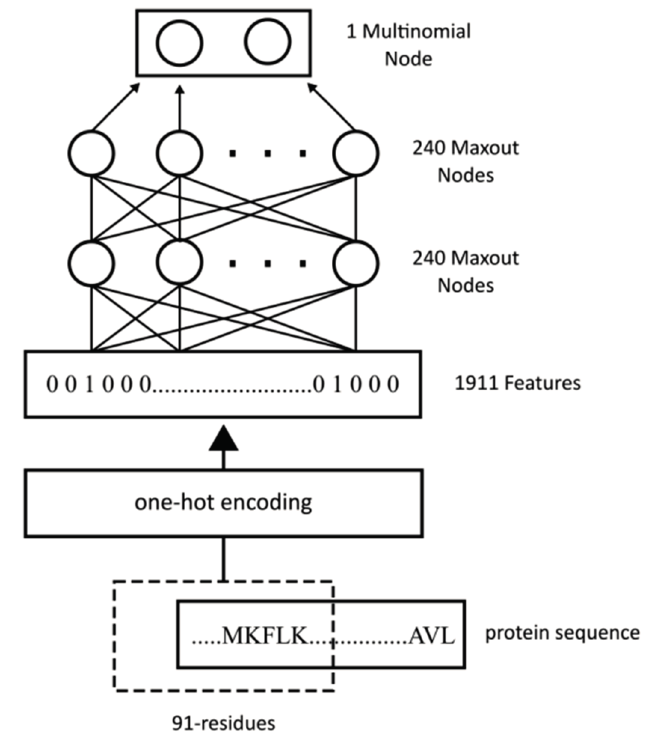
Figure 4. General deep network architecture used for Tier 1 order/disorder